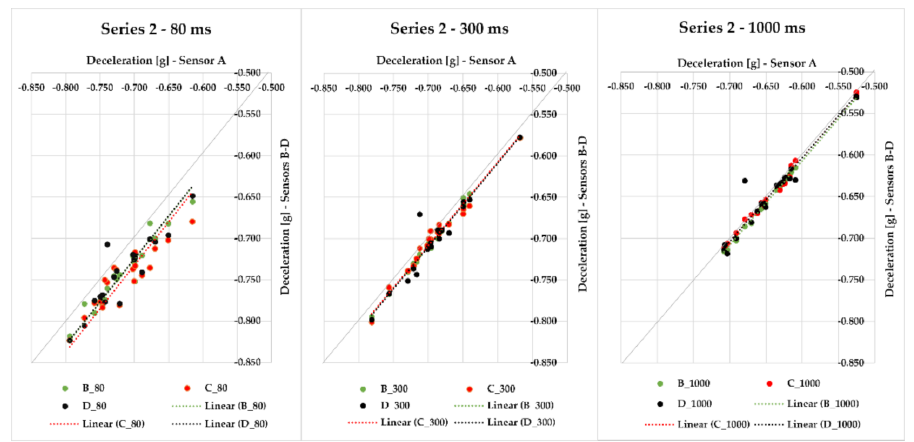
Figure 8. Series 2-Point dependency of individual MEMS sensors against sensor